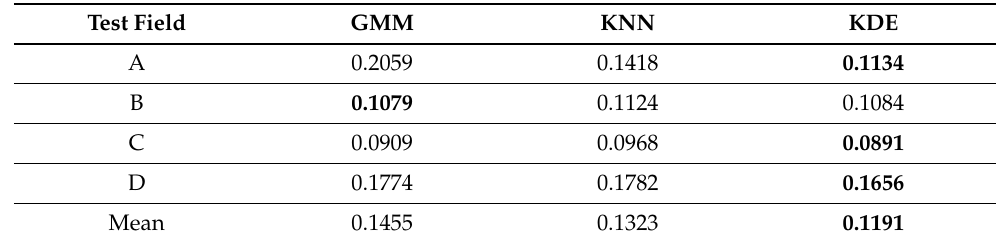
Table 6. Root-mean-squared error between the true CF and that predicted by the GMM, KNN, and KDE for each cross-validation